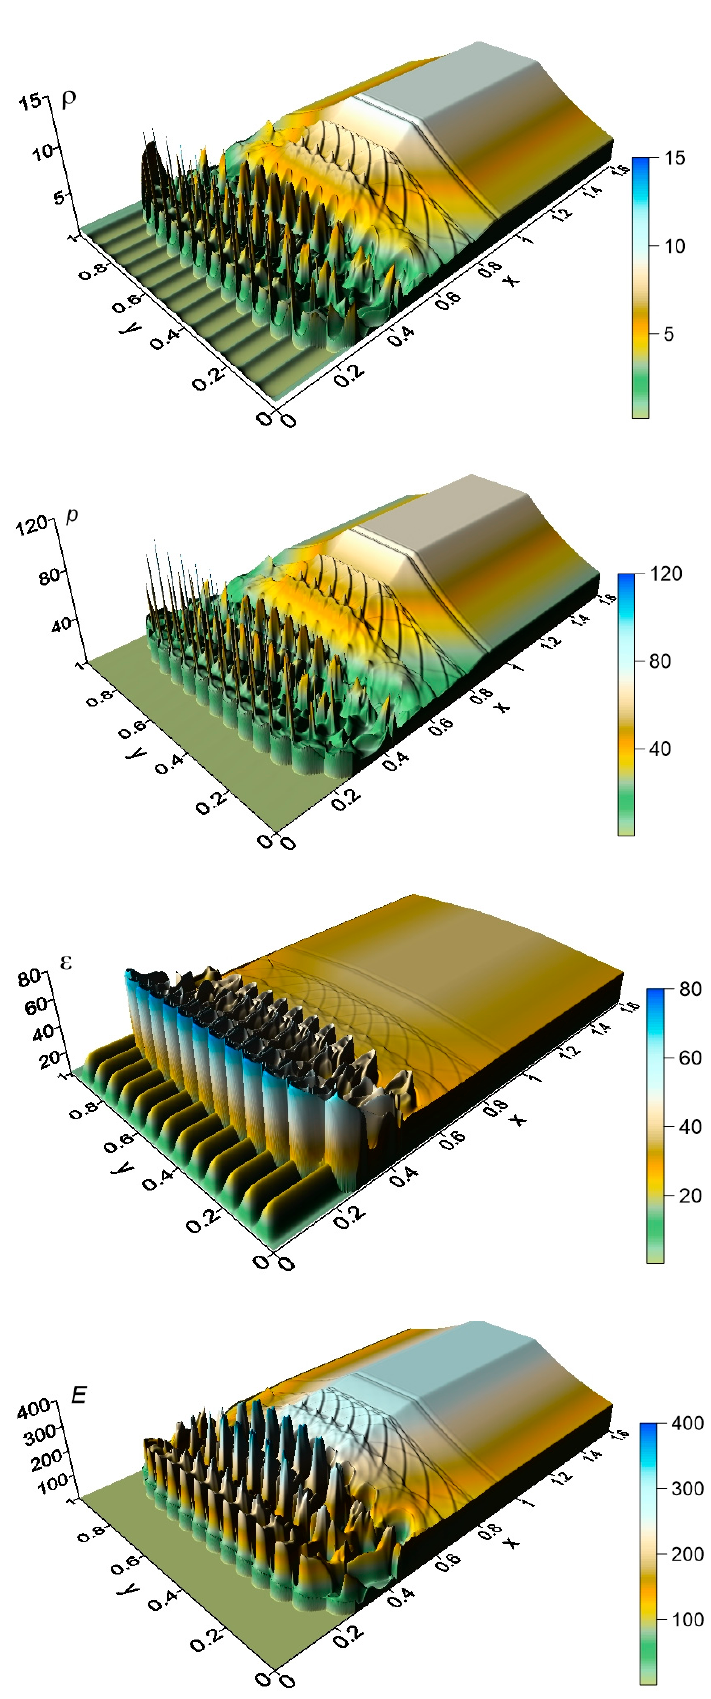
Figure 7. Fields of the considered parameters ( ρ , p , ε and E ): M = 8, α = 0.1, t = 0.12.